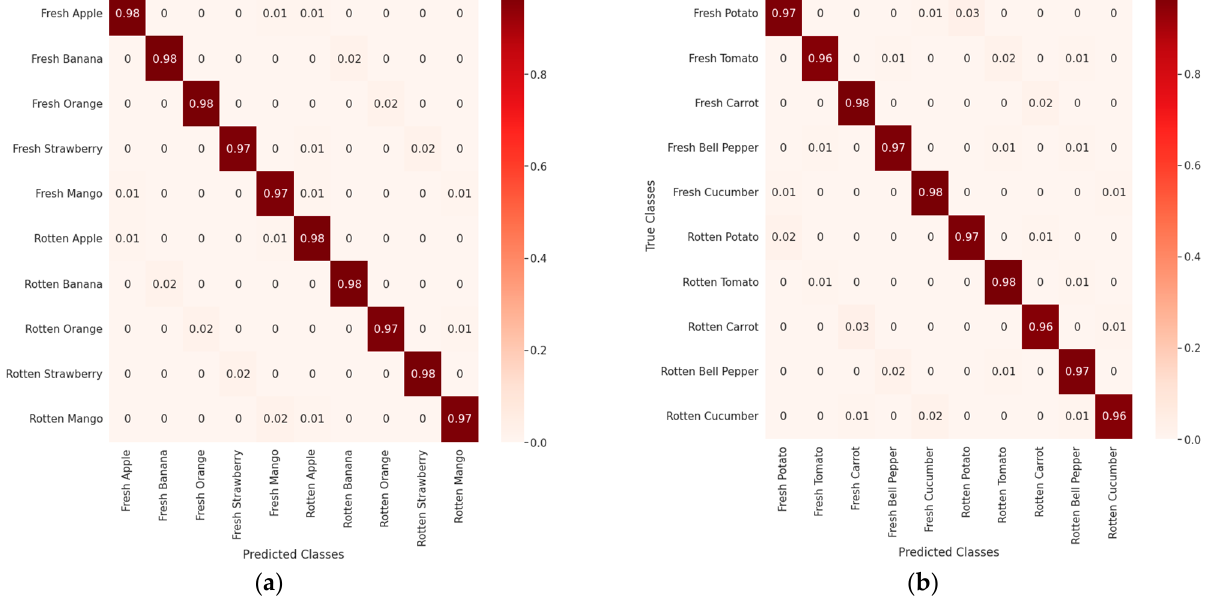
Figure 8. Results of the confusion matrix ( a , b ) for the classification of fruits and vegetables, respec- tively, using the improved